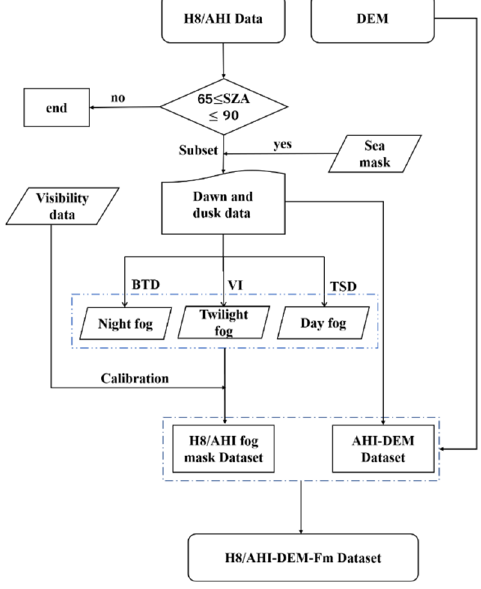
Figure 5. The process of making the H8/AHI-DEM-Fm dataset. (1) Building the AHI-DEM dataset at dawn and